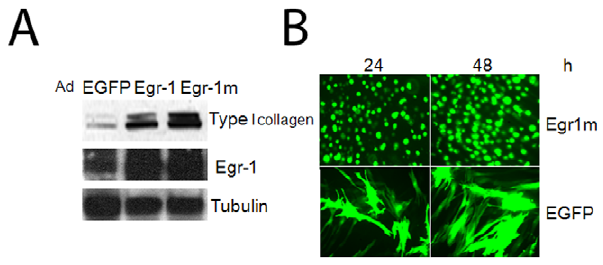
Figure 1. Adenovirus-mediated Egr-1 expression in human skin fibroblasts. Confluent dermal fibroblasts were infected with Ad-EGFP, Egr-1 or Egr-1m (100 MOI) for 48 h. A. Cultures were harvested and whole cell lysates were subjected to Western analysis. Representative immunoblots. B. Fibroblasts were examined by fluorescence microsco- py. Representative image. (Original magnification 6